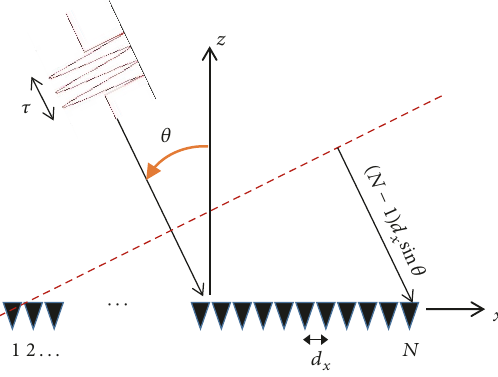
Figure 1: Increase in the bandwidth of the wireless standards over time [1].